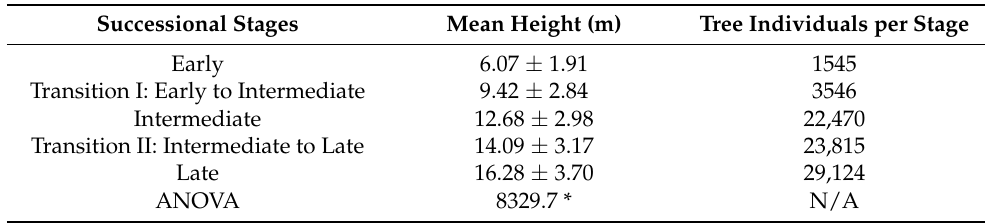
Figure 6. Canopy height variability of successional stages at the SRNP-EMSS, Guanacaste, Costa Rica, derived from a canopy height model (CHM) over Early, Transition I: Early to Intermediate, Intermediate, Transition II: Intermediate to Late, and Late successional stages. Table 3. Mean values with one standard deviation of canopy height with three successional stages and two transitions at the SRNP-EMSS were extracted from LiDAR data. Significant differences (F values) according to the successional stages are presented from ANOVA. Height was extracted in meters and tree individuals per